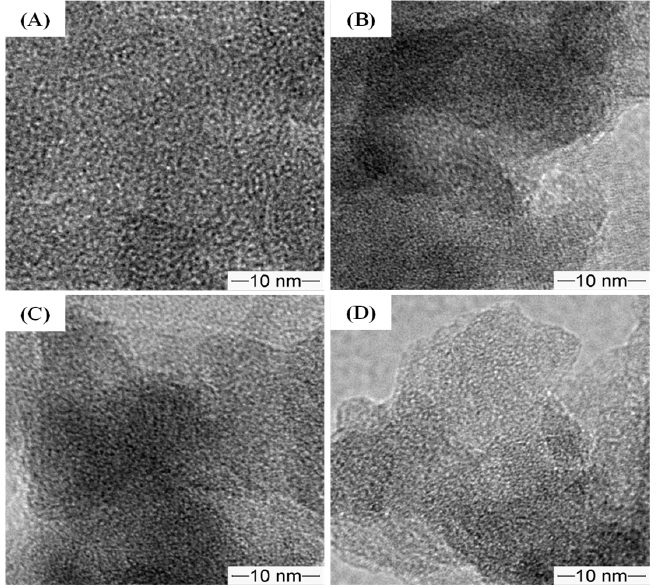
Figure 7. TEM images of ( A ) WMS, ( B ) WMS-0.10, ( C ) NR/WMS and ( D ) NR/WMS-0.10 at magnifi- cation of 100,000×.